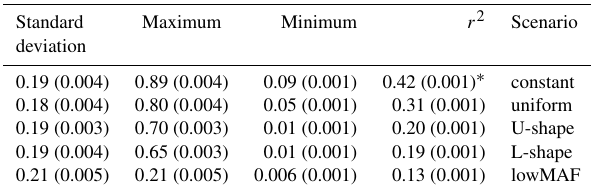
Table 3. Mean of linkage disequilibrium value ( r 2 ) between QTL and adjacent SNPs for different distributions of QTL allele fre-